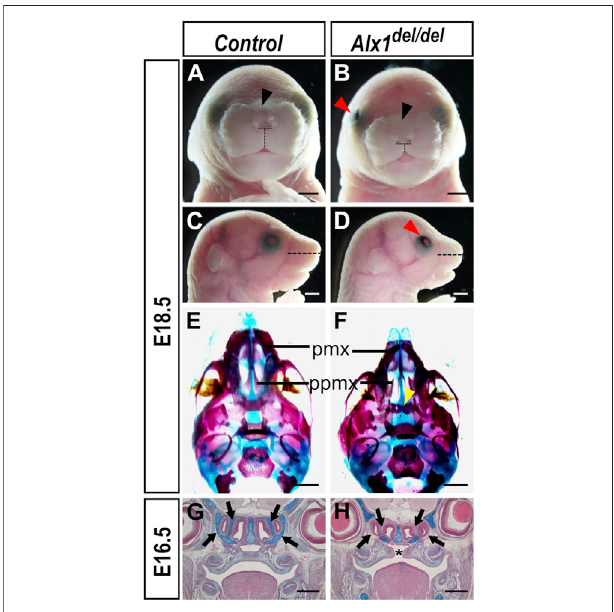
FIGURE 2 | Craniofacial defects in the Alx1 del/del embryos. (A – D) Whole mountfrontal (A,B) andlateral (C,D) viewsofcontrol (A,C) and Alx1 del/del (B, D) embryosatE18.5. Alx1 del/del embryosexhibitopeneyelid[redarrowheadin (B, D) ], shorter snout [compare horizontal dashed lines in (C, D) ], wider nasal bridge [black arrowhead in (B) ] and notching of the upper lip. Dashed horizontal lines in A and B mark the inter-nostril distance, whereas vertical dashed lines mark the length of the philtrum for measurements in Supplementary Figure S1 . (E, F) Palatal view of the head skeleton preparations of E18.5 control (E) and Alx1 del/del (F) embryos. Alx1 del/del embryos exhibit hypoplastic premaxilla, malformed palatal processes, and hypoplastic presphenoid bone [yellow arrowhead in (F) ]. (G, H) Frontal sections ofcontrol (G) and Alx1 del/del (H) embryoheadsatE16.5.AsteriskinH marks the cleft palate. Black arrows point to the lateral nasal cartilages in the wildtype control (G) and the defective nasal cartilages in the Alx1 del/del embryos (H) . Scale bars in (A – F) and (G, H) are 500 µm and 1 mm, respectively. pmx, premaxilla; ppmx, palatal process of the maxillary